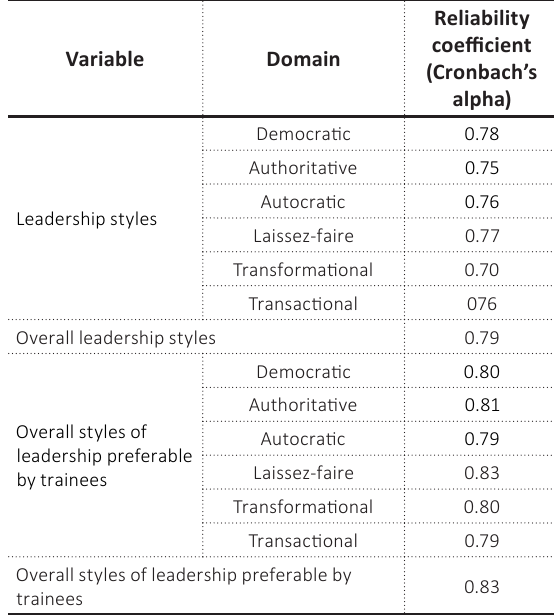
Table 3. Cronbach’s alpha reliability coefficients